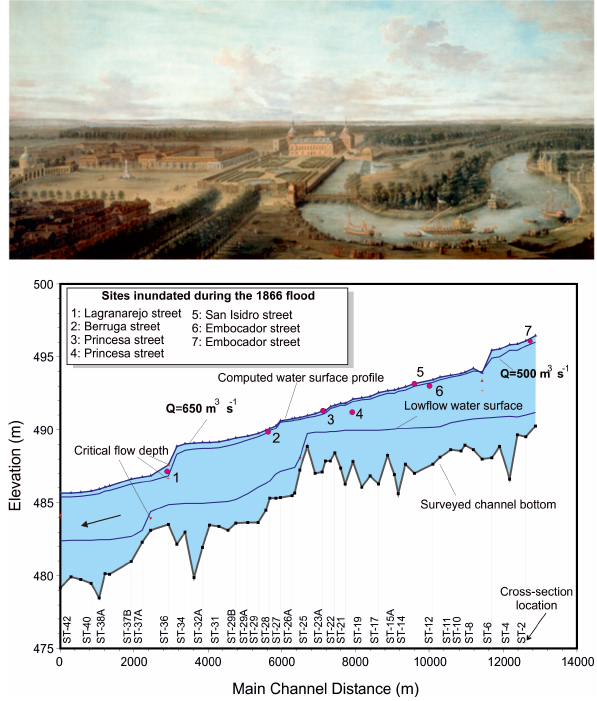
Figure 2. Above: Royal Palace of Aranjuez with a view of the Tagus River and gardens painted by Antonio Joli, ca. 1753. Bottom: lon- gitudinal profile of the channel bottom along the study reach and calculated water surface profiles fitting historical flood water indi- cators described as inundated during the 1866 flood. An estimated discharge of 650m 3 s − 1 was assigned to this flood. Note the water surface profile for baseflow